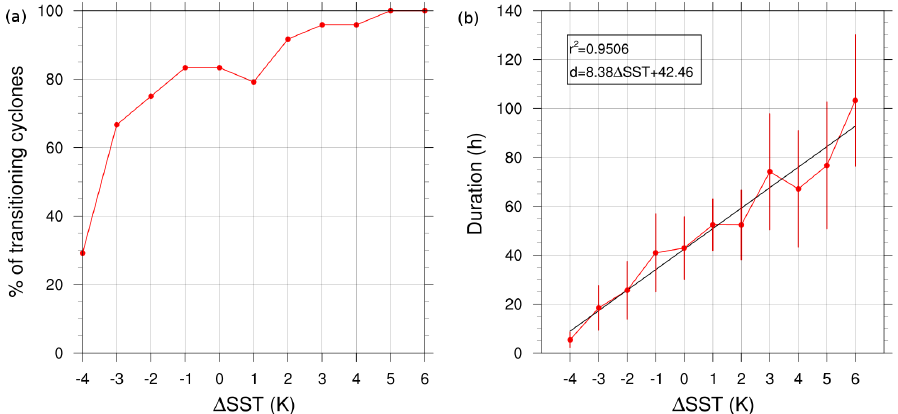
Figure 2. (a) Percentage of cyclones encountering a tropical transition over the 24-member ensembles for different SST changes, using classification criteria based on the cyclone phase space. (b) Mean period of time during which transitioning cyclones are classified as medicanes for different SST changes. Error bars represent standard deviation. The black line is based on a linear regression.